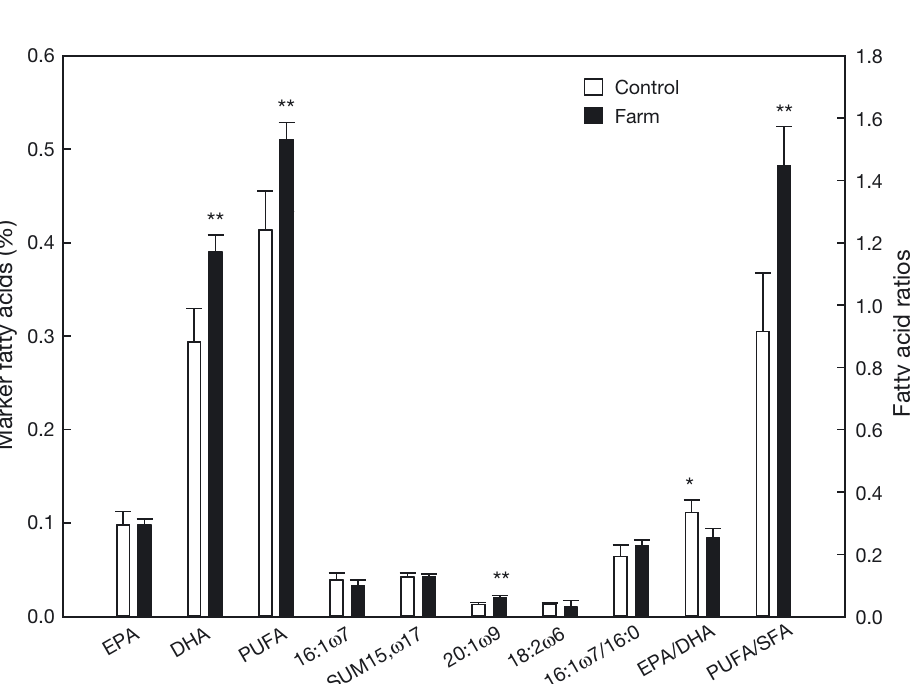
Fig. 6. Marker fatty acids (FA), with values shown for relative FA composition and FA ratios, in the harpacticoid copepod fam- ily Canuellidae at ‘farm’ and ‘control’ sites at Stn SS (see Table 1 legend for abbreviation), during seasonal aquaculture at a scallop farm in Laizhou Bay, China in 2016 . Eicosapentaenoic acid (EPA), docosahexaenoic acid (DHA) and polyunsaturated fatty acids (PUFA) are indicative of food quality. Other biomarkers shown are: 16:1 ω 7 and 16:1 ω 7/16:0 (indicative of diatoms in the diet); EPA/DHA (diatoms/dinoflagellates); SUM 15,17 (i.e. the sum values of 15:0, 17:0, 17:1 ω 7 in this study; indicating bacterial FAs); 18:2 ω 6 (terrestrial detritus or green algae); 20:1 ω 9 and PUFA/SFA ratio (indicative of carnivory). Asterisks show significant differences between values for ‘farm’ and ‘control’ based on the results of t -tests: **p < 0.01; *p <